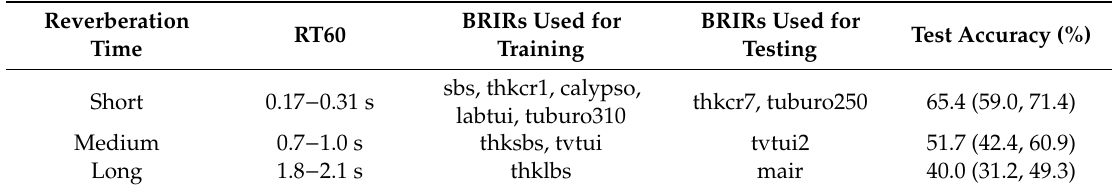
Table 7. Accuracy of classification (%) obtained for models trained and tested using the recordings synthesized with BRIR sets of similar reverberation time. Numbers in brackets represent 95% confidence intervals.